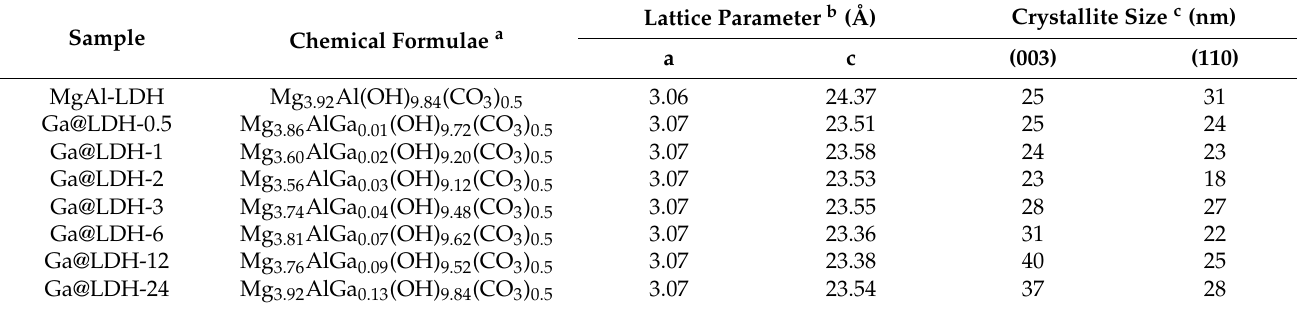
Table 1. Chemical formula, lattice parameters and calculated crystallite sizes of parent MgAl-layered double hydroxide (LDH) and Ga@LDH-n (where n stands for the reaction time in hours). Sample Chemical Formulae a